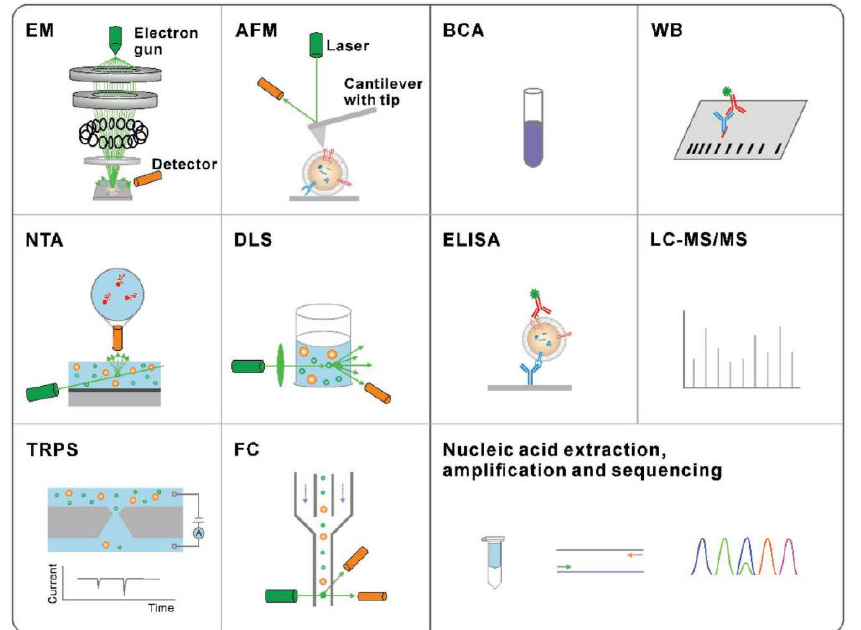
Figure 4. Traditional methods for the characterization of exosomes. Characterization techniques to measure physical properties (morphology, size, and zeta potential) (Reproduced with permission from Wang W. et al. [39]. Copyright 2018, John Wiley and Sons).